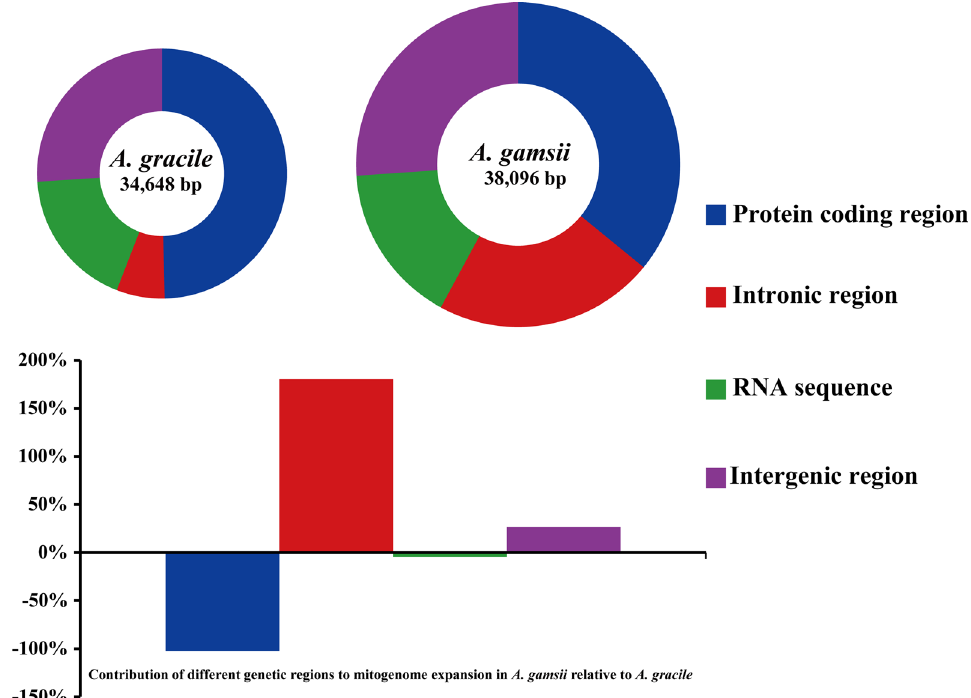
Fig. 3 The protein-coding, intronic, intergenic, and RNA gene region proportions of the entire mitogenomes of the two Apiotrichum species. The bottom panel shows the contribution of different gene regions to the expansion of the A. gamsii mitogenome